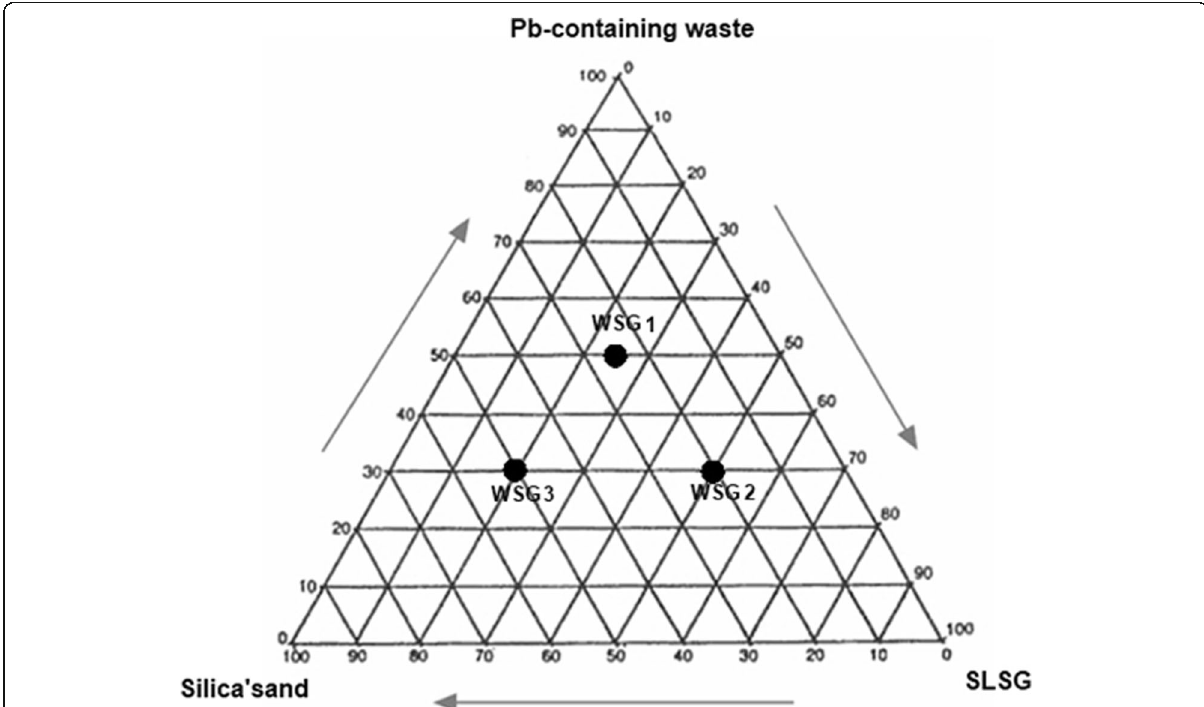
Fig. 1 Triangle of the ratio of Pb-containing wastes, silica ’ sand and soda-lime-silica